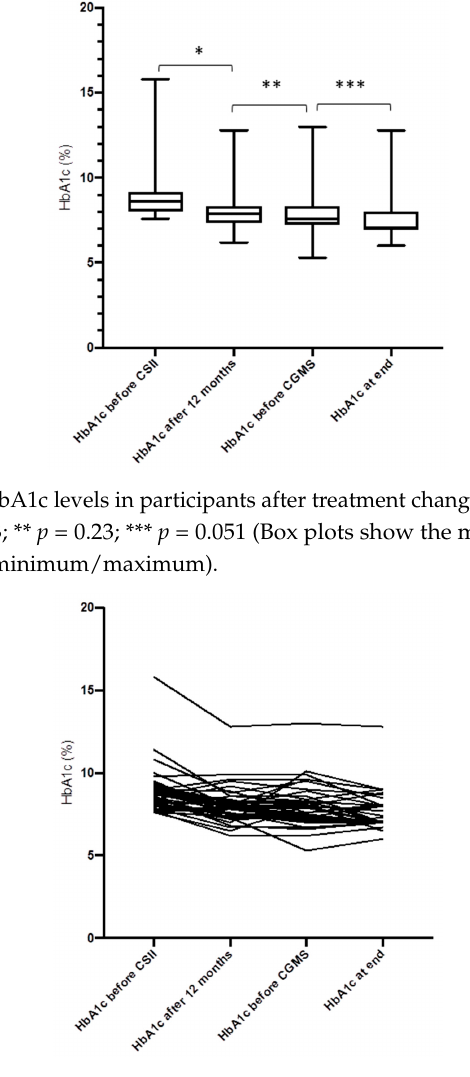
Figure 3. Individual course of the HbA1c levels over the entire study duration ( n = 41). Table 3. Diabetic and microvascular complications diagnosed during follow-up. Intervention Group ( n =